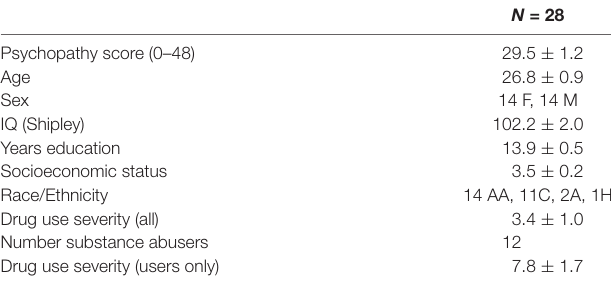
TABLE 1 | Participant demographic